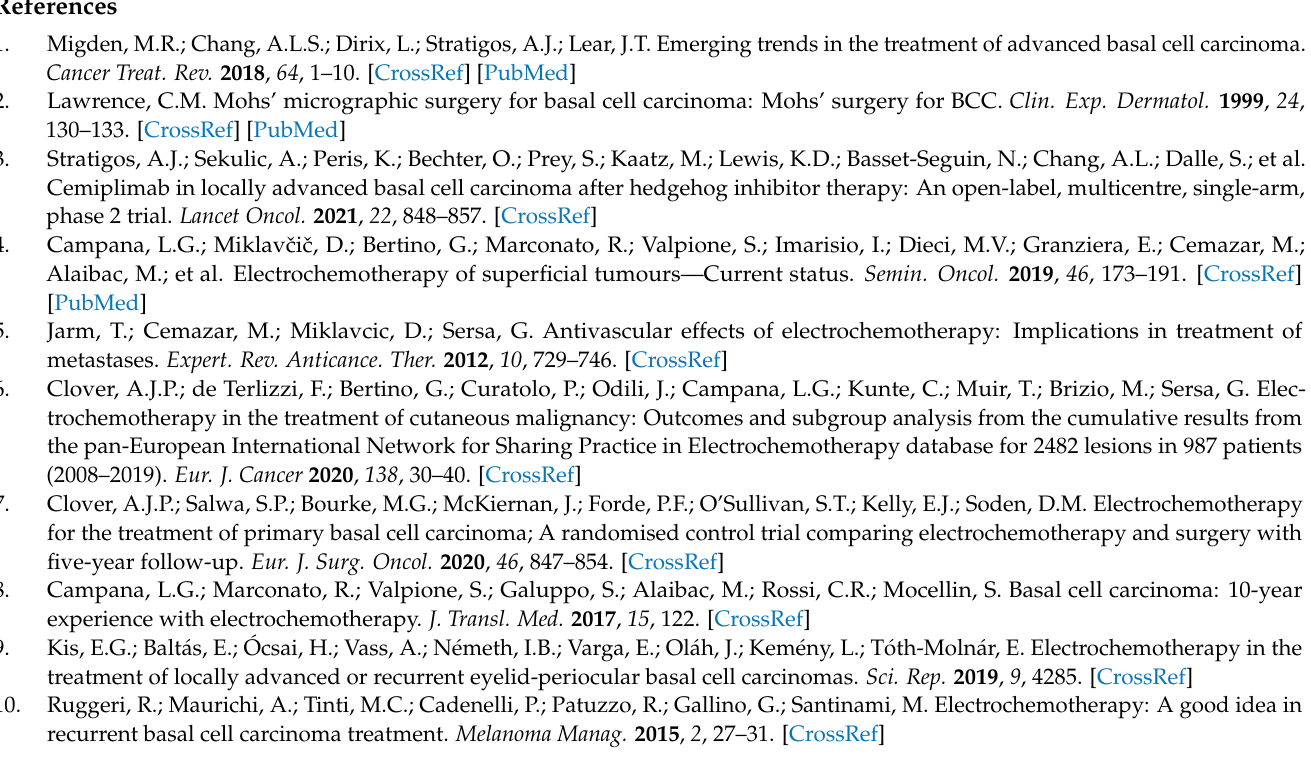
Table S2: Patient characteristics according to development or not of local recurrence; Table S3: Clinical studies on ECT in unselected cancer populations, including patients with BCC